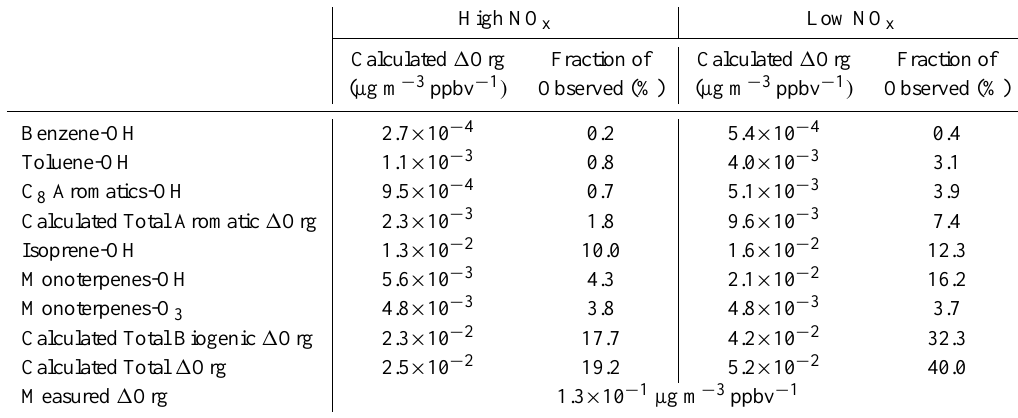
Table 2. Calculated Contributions to Secondary Organic Aerosol Formation for the Detroit Air period (all normalized to